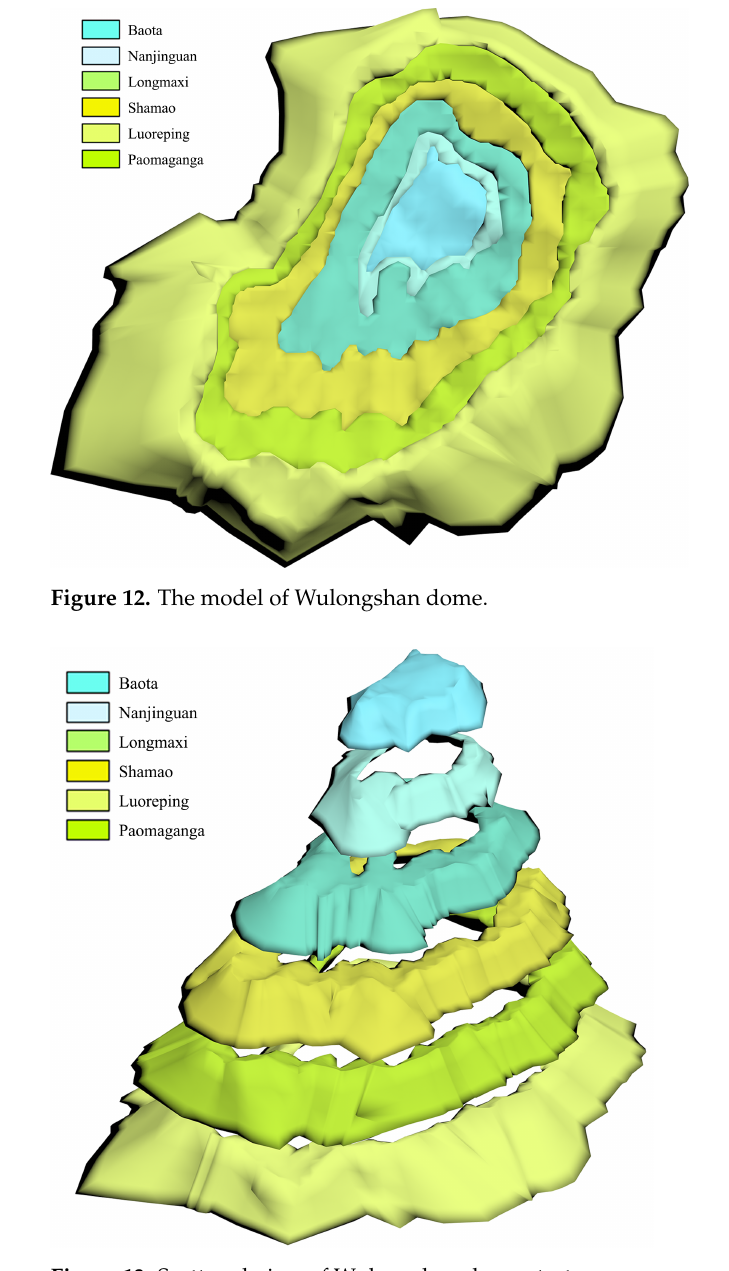
Figure 13. Scattered view of Wulongshan dome strata. Deng [49] drew a geological section of the Wulongshan dome based on seismic data (Figure 14a) after studying the structure of the Huangling dome and neighboring areas. tectonic stress; that is, the stratum on the South side is formed by wedging the